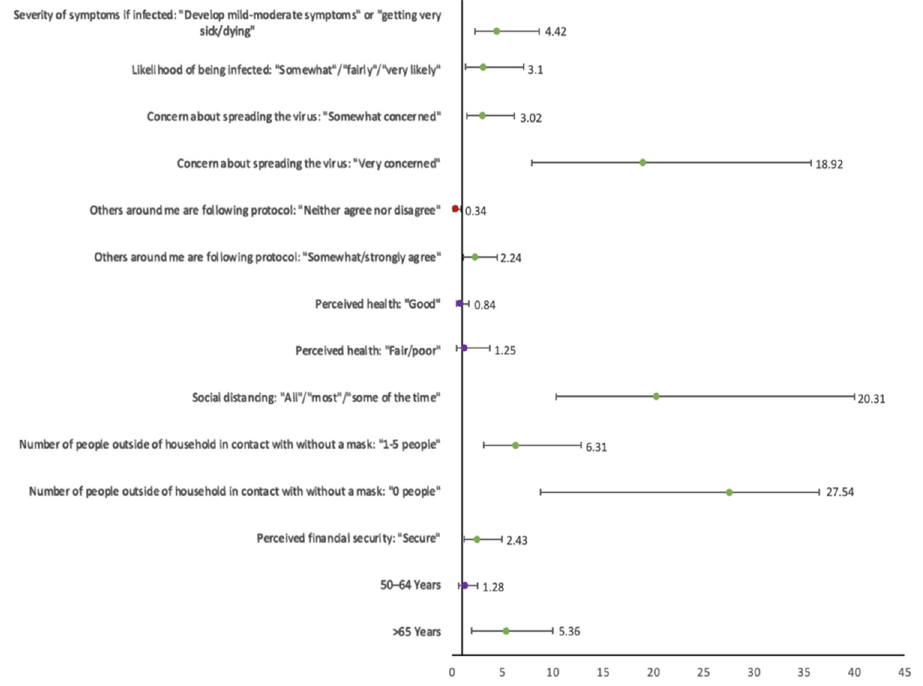
Figure 1. The odds ratios of covariates associated with the dual behavior, consistent mask wearing and vaccine acceptance. Green = protective effect; red = negative effect; purple = not statistically significant.